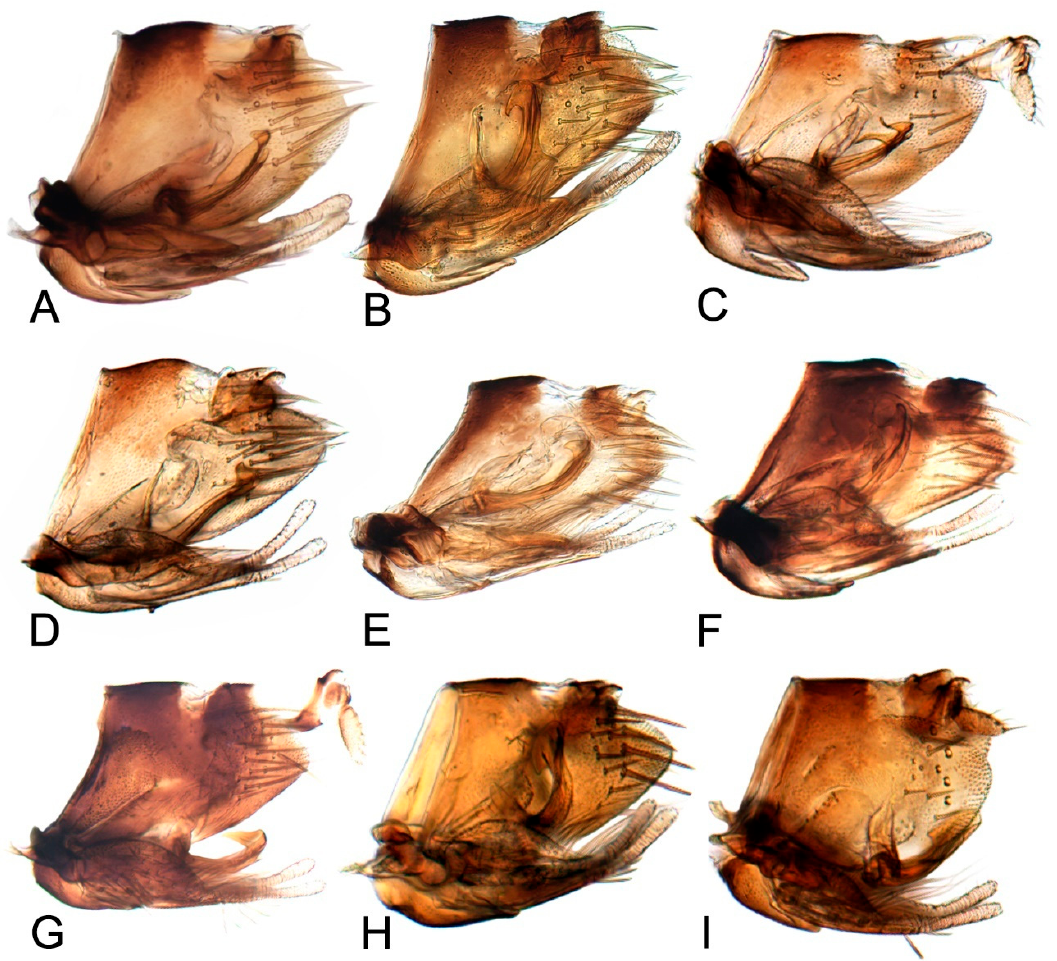
Figure 9. Male pygofer, lateral view: ( A ) H. expansivus ; ( B ) H. ventralis ; ( C ) H. hamuleus ; ( D ) H. yuanmouensis ; ( E ) H. hamatus ; ( F ) H. fuscomaculatus ; ( G ) H. lii ; ( H ) H. phycitis ; and ( I ) H. paraphycitis .